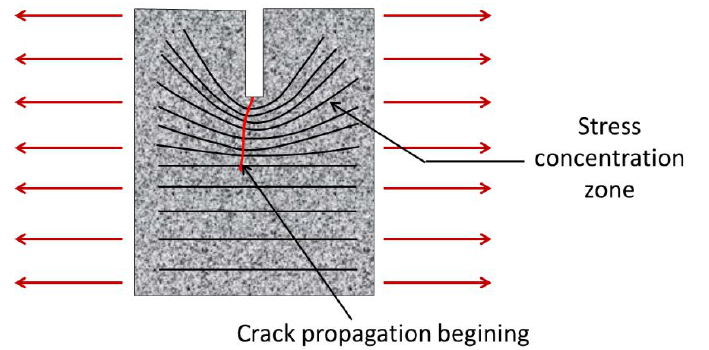
Figure 1. Stress concentration in the notch tip of cubic concrete specimens (adapted from Balbo,